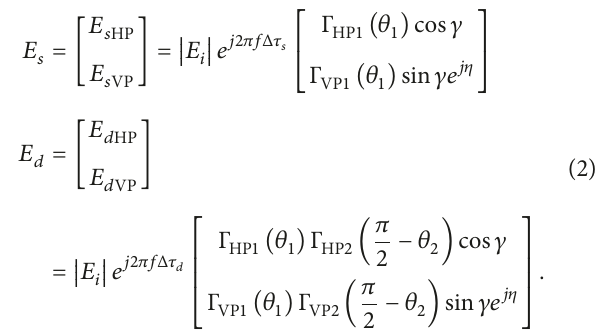
polarization of incoming wave, 𝛾 = 45 ∘ , and 𝜂 = − 90 ∘ for RHCP